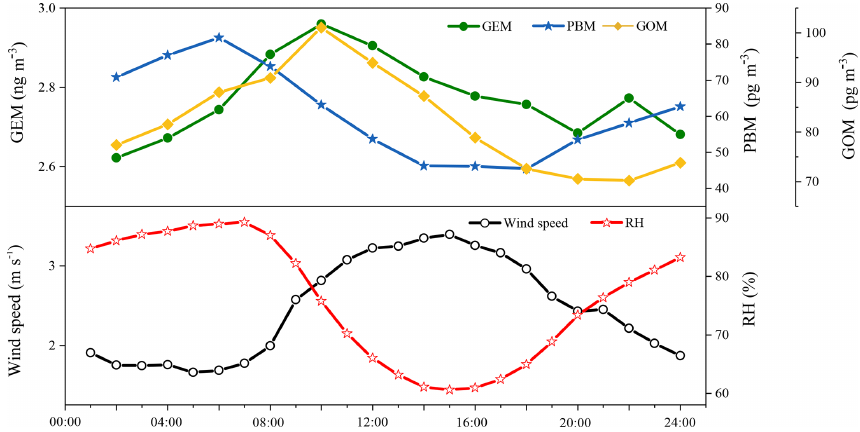
Figure 4. Annual mean diurnal variation in GEM, PBM, and GOM